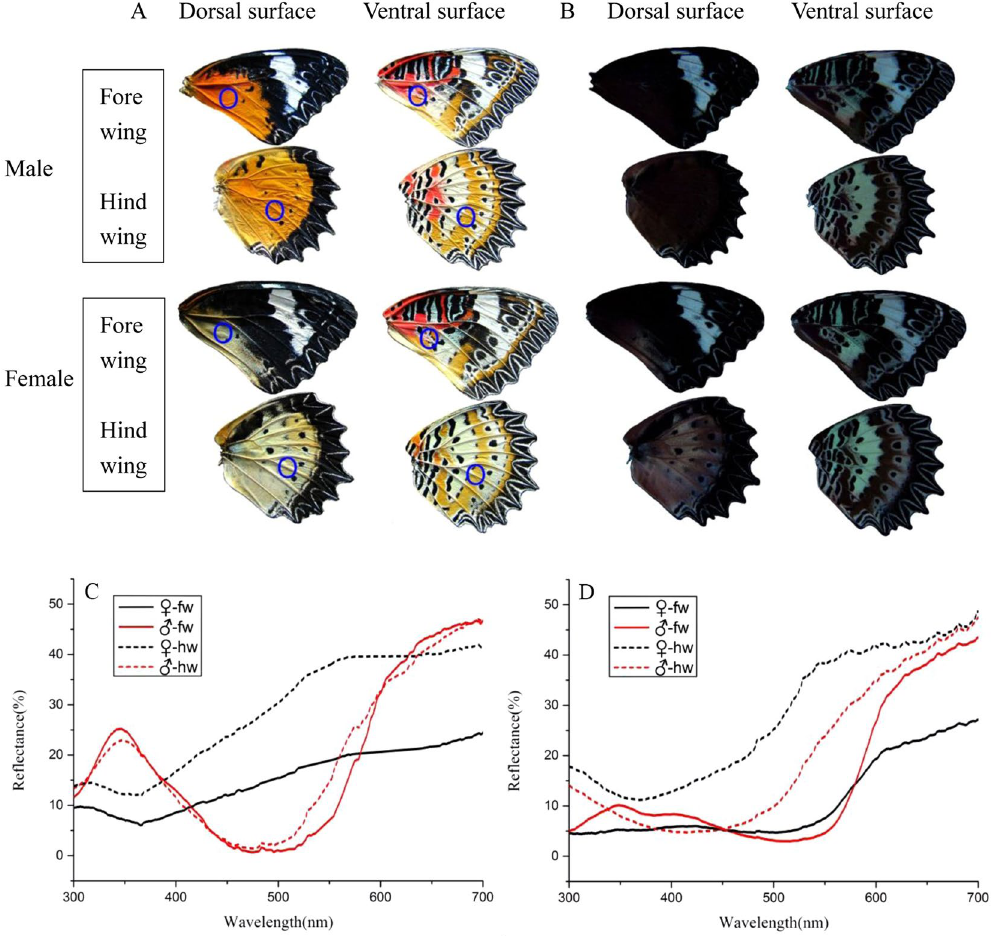
Figure 4. The wings of Cethosia cyane cyane . ( A ) Photographed under sunlight; ( B ) Photographed under UV light; ( C ) Reflectance spectra of the dorsal wings of male and female; ( D ) Reflectance spectra of the ventral wings of male and female. fw: forewing, hw: hindwing. Circles on the wings depict the portion subjected to spectrophotometric analysis.